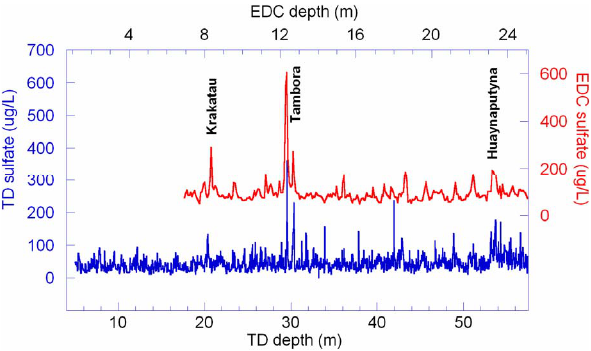
1 Figure 2. Sulphate profiles of the top parts of the EDC and Talos Dome ice cores spanning the 2 Fig. 2. Sulphate profiles of the top parts of the EDC and Talos last four centuries of volcanic history recorded in Antarctic ice. Three known and well-dated 3 Dome ice cores spanning the last four centuries of volcanic history volcanic events are pointed out: Krakatau (1884 AD), Tambora (1815 AD) and Huaynaputyna 4 recorded in Antarctic ice. Three known and well-dated volcanic (1600 AD). 5 events are pointed out: Krakatau (1884AD), Tambora (1815AD) and Huaynaputyna